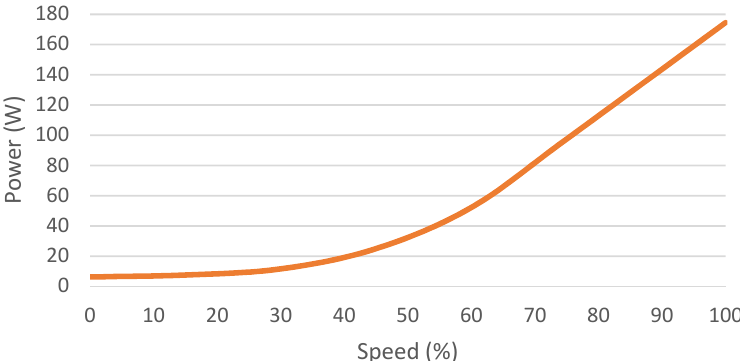
Figure 14. Ventilator power-speed curve.